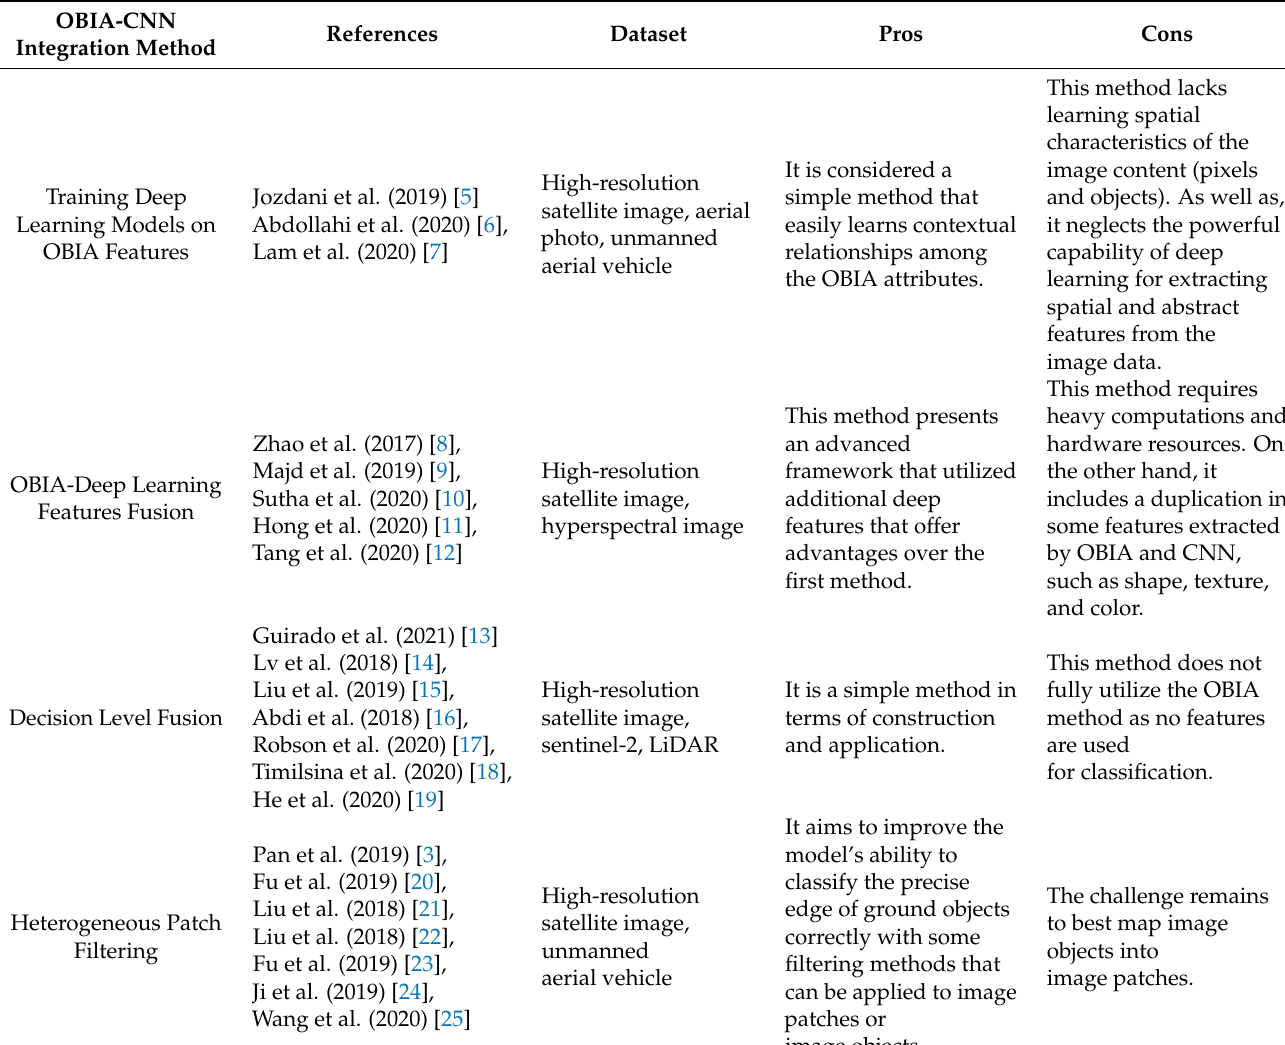
Table 1. The summary of OBIA-CNN integration